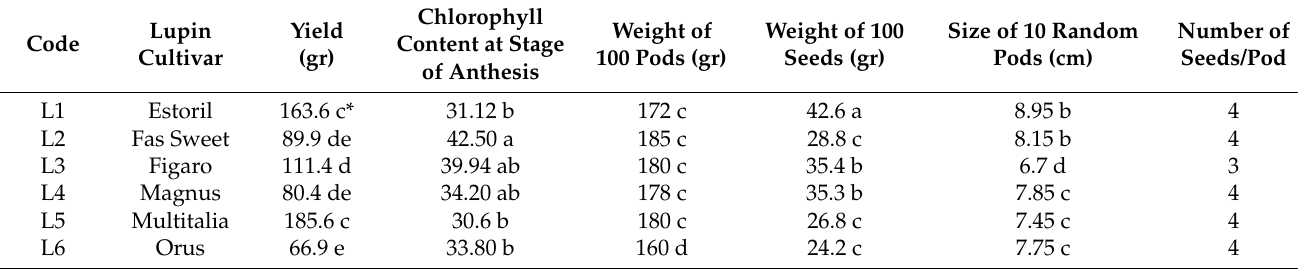
Table 5. Yield components of Lupin